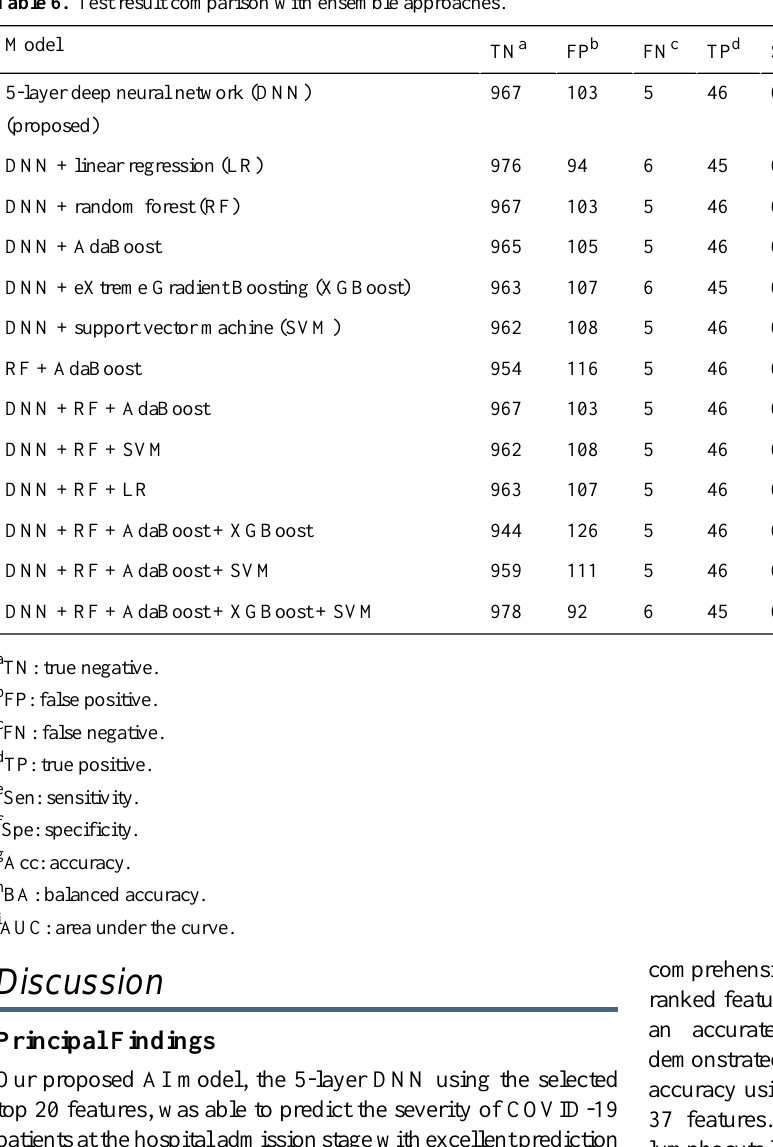
Table 6. Test result comparison with ensemble